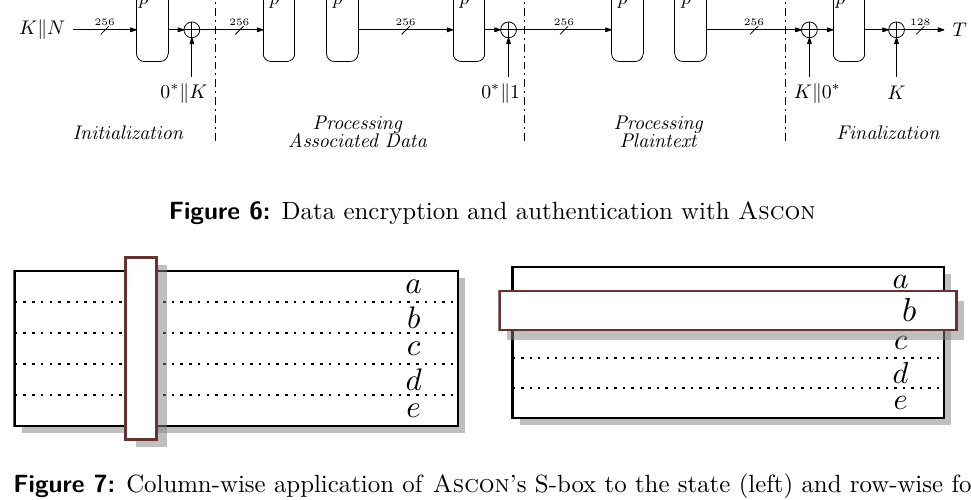
Figure 7: Column-wise application of Ascon ’s S-box to the state (left) and row-wise for the linear layer (right), duplicated state rows are